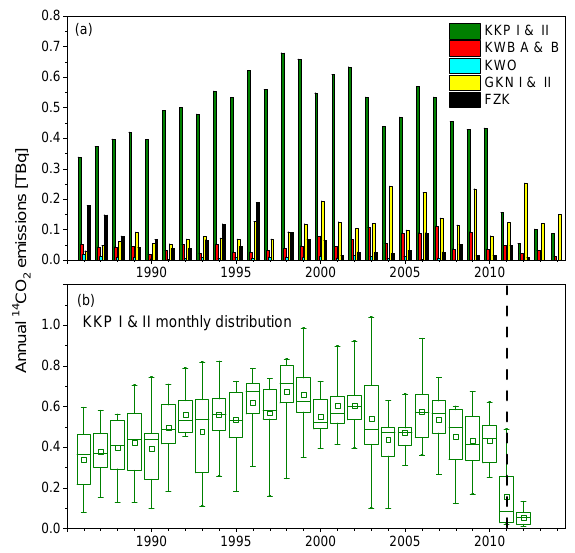
Figure 2. 14 CO 2 emissions from nuclear facilities: annual mean emissions from all facilities (a) and box plots of the distribution of monthly values from Philippsburg (KKP I and II, b ); the boxes include 50% of all months of the year with the horizontal bar indi- cating the mean and the square indicating the median value of the year. The whiskers show the minimum and maximum monthly val- ues of the individual years. The dashed line indicates the shutdown of Philippsburg I shortly after the Fukushima